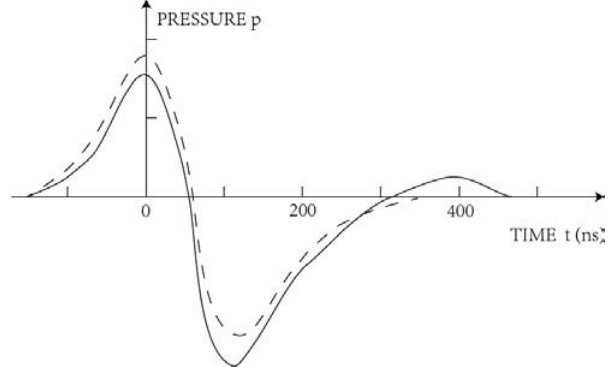
Fig. 8. Theoretical thermoelastic acoustic wave according to Markus Sigrists model (dashed cure) his experimental result (solid curve).